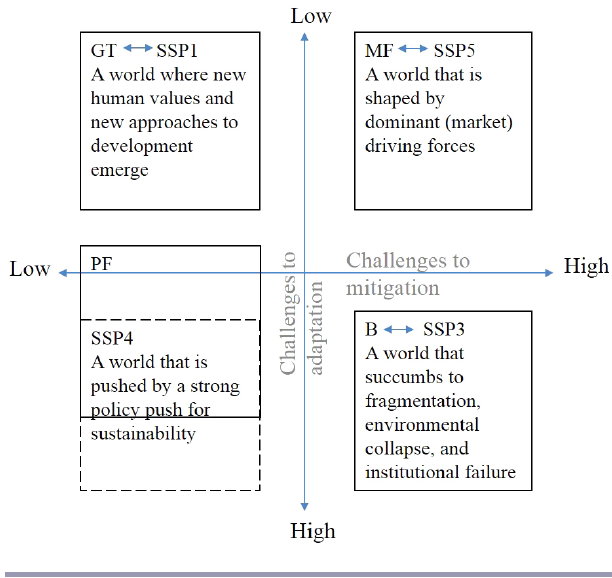
Fig. 1 . Four archetypical social visions of the world from the Global Scenario Group (adapted from Hunt et al. 2012, Raskin 2005), matched to global shared socioeconomic pathways (SSPs; O’Neill et al. 2017). SSP axes are in gray, and dotted lines indicate partly unmatched archetype. B, barbarization; GT, great transitions; MF, conventional market force; PR, conventional policy reform.